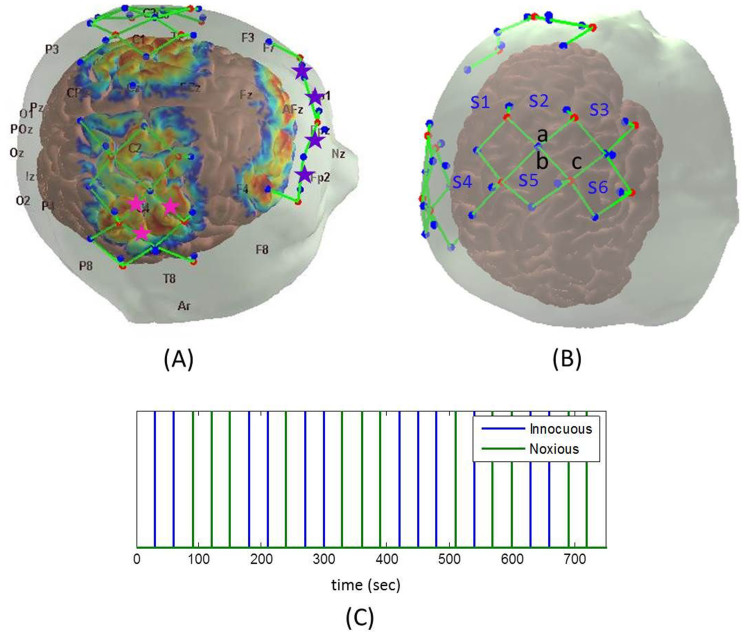
Probe placement and stimulus paradigm.The locations of the detectors (blue dots), the sources (red dots), the channels (green lines) and the sensitivity profile are shown for one subject (panel A). The optodes and the channels are displayed on the scalp and the sensitivity profile is displayed on the cortex. The sensitivity profile is displayed on a logarithmic scale and spans two orders of magnitude (arbitrary units). The channels used for frontal (purple) and motor-sensory (pink) regions are labelled with stars. The letter-number combinations on panel B (long separation channels: a, b, c and short separation channels: s1 to s6) correspond to the same letter-number combinations on Figure 1, Figure 6 and Table 1. Panel C: Stimulus paradigm: innocuous stimuli (blue lines), noxious stimuli (green lines).